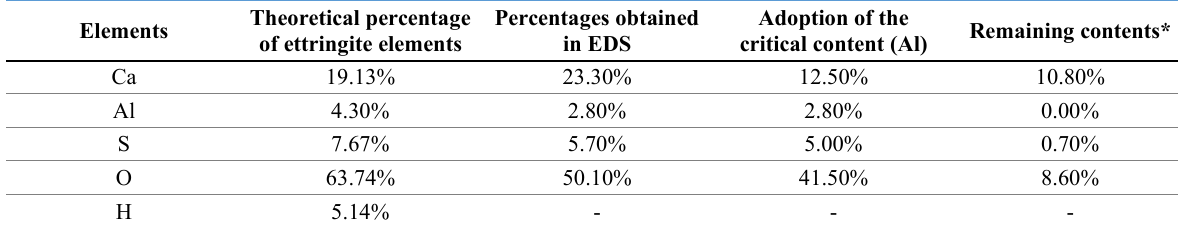
Table 4. Proportion of elements for EDS analysis of